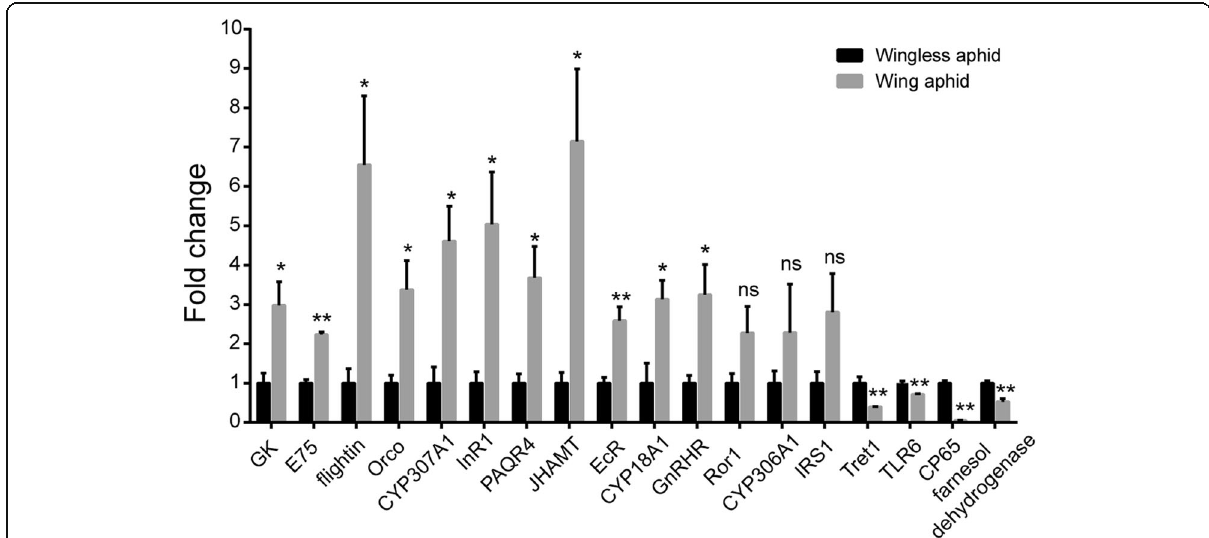
Fig. 6 Relative expression levels of 18 selected genes measured by RT-qPCR method. 18 DEGs potentially involved in the regulation of cotton aphid wing determination were validated by RT-qPCR method. *, P < 0.05 and **, P < 0.01 compared with the respective wingless aphid levels in wing aphid adult. n = 4. ns, no significant